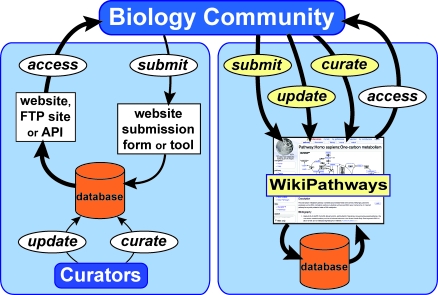
Two Models for Managing Biological DataCurrent biological databases provide the community with data submission forms or tools and access to the compiled data via websites, FTP sites, and, sometimes, programmatic interfaces (API). Internal curation teams organize and update the data. A wiki model for biological databases, such as WikiPathways, provides a single, intuitive interface for submitting, updating, organizing, and accessing data, allowing the community to participate in the curation process and keep up with the influx of new data. The widths of the arrows represent the relative capacity for data management in the two models.